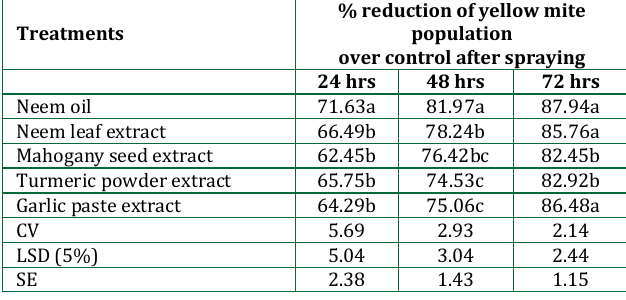
Table 2: Effect of different plant extracts on the reduction of yellow mite population over control